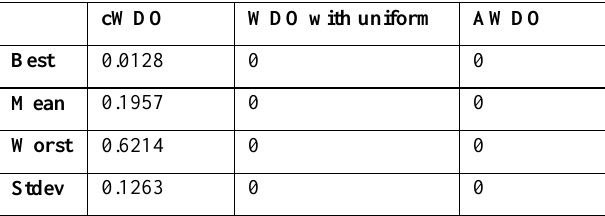
Table 4. Results of Griewank in search space of [-600, 600] N=10